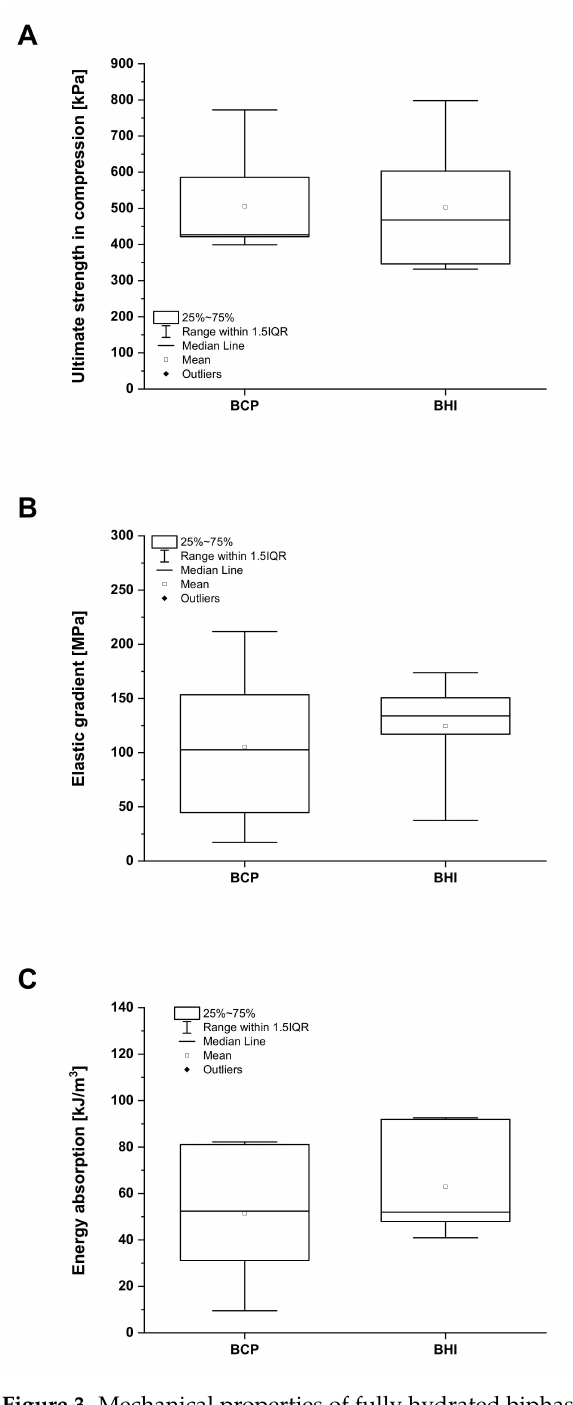
Figure 3. Mechanical properties of fully hydrated biphasic calcium phosphate scaffold (BCP) and bioresorbable hybrid implant (BHI). Ultimate strength in compression ( A ), elastic gradient ( B ), and energy absorption ( C ). No statistical significance (Mann–Whitney test, p <